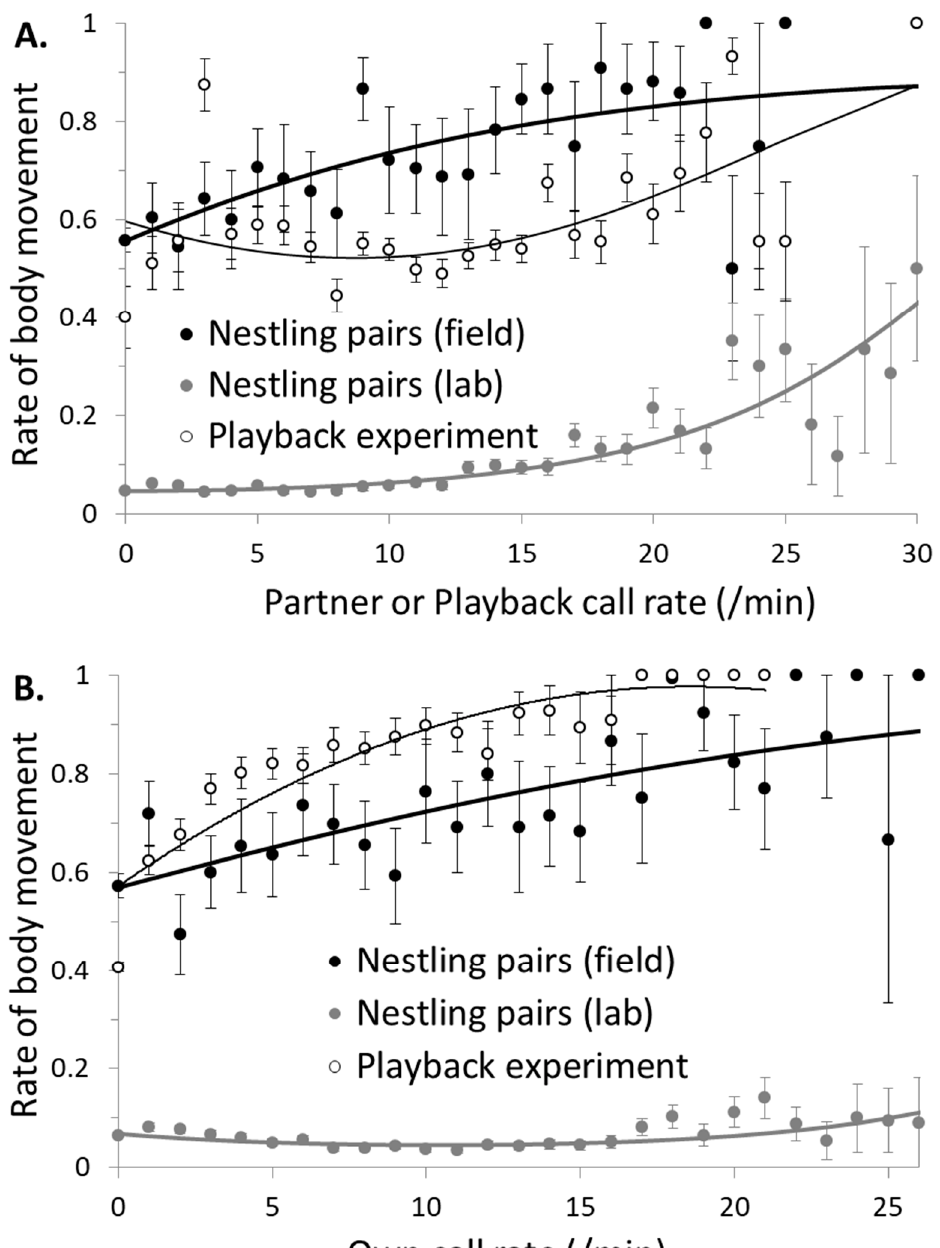
Figure 1. Body movements (occurrence in each minute) of focal barn owl nestlings according to ( A ) partner’s call rate and ( B ) nestling’s own call rate. Behaviors were recorded in pairs of nestlings in their natural nest (black symbols, experiment 1) or in the laboratory (grey symbols, experiment 2), but also in singleton nestlings to which playback calls were broadcast at different rates (open symbols, experiment 3). Bars represent standard errors and lines are estimates of the models. The different types of body movements were not differentiated.